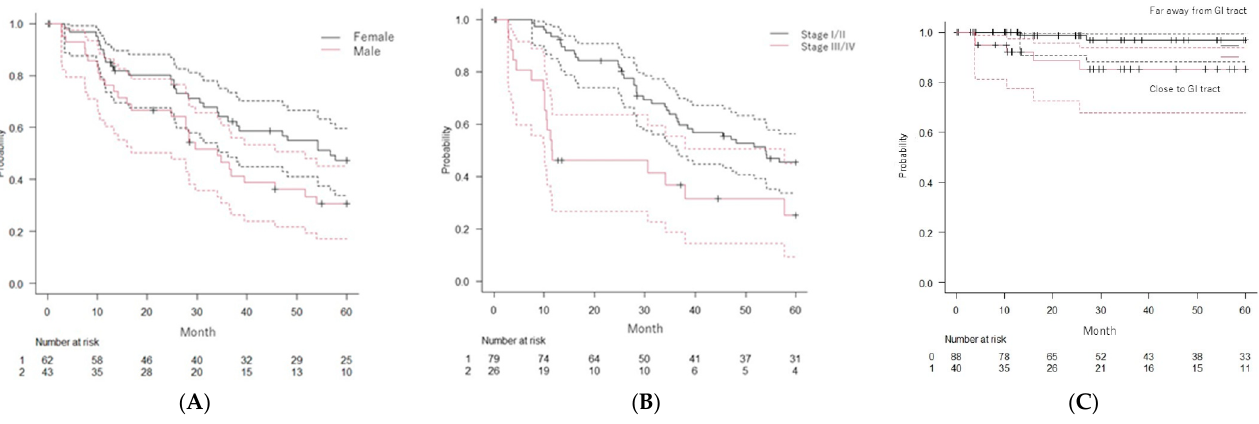
Figure 2. Kaplan–Meier estimates of overall survival (OS) according to ( A ) sex, and ( B ) UICC-stage. ( C ) Kaplan–Meier estimates LTC according to HCC located within 2 cm of the gastro-intestinal (GI) tract. Dotted lines represent 95% confidence intervals.